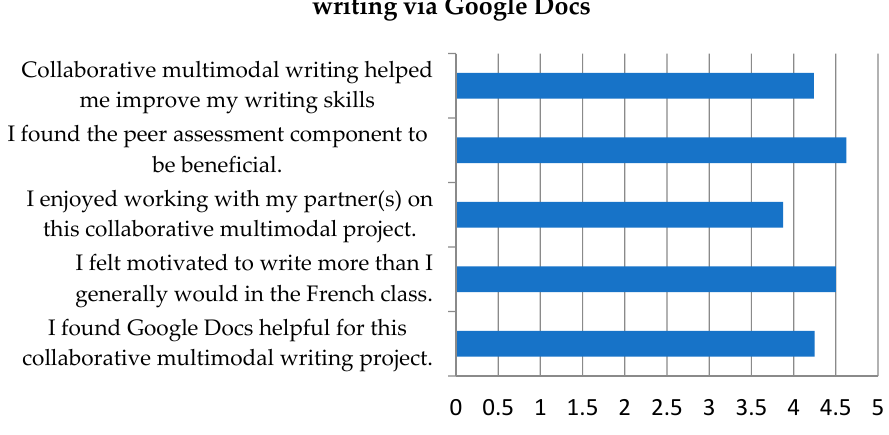
Figure 2. Post-task survey results: perceived benefits of collaborative multimodal writing via Google Docs (1: strongly disagree, 2: disagree, 3: neutral, 4: agree, 5: strongly agree).